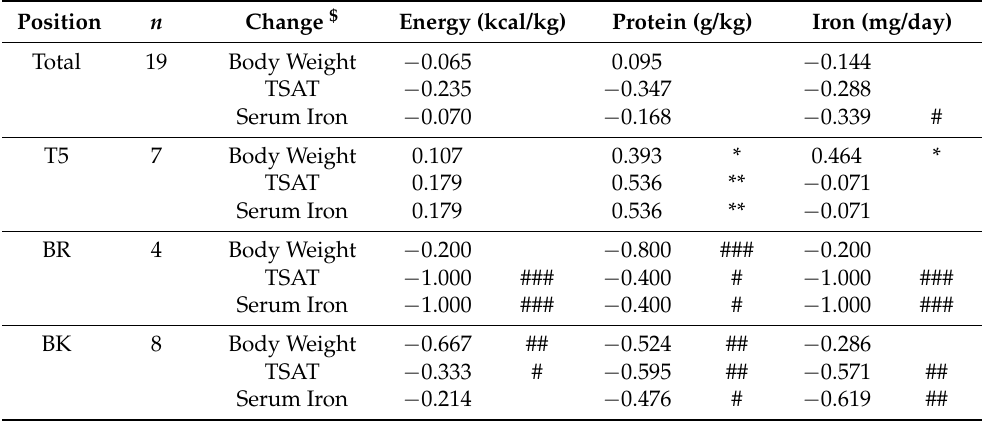
Figure 3. Correlations of changes in body weight with changes in ( A ) transferrin saturation (TSAT) and ( B ) serum iron level. Change was calculated as (Post − Pre)/Pre (%). Tight-5 (numbers 1–5); Back row (numbers 6–8); and Backs (numbers 9–15). Table 3. Spearman’s correlation coefficient between the change in body weight, TSAT, and iron versus change in intakes of energy, protein, and iron.